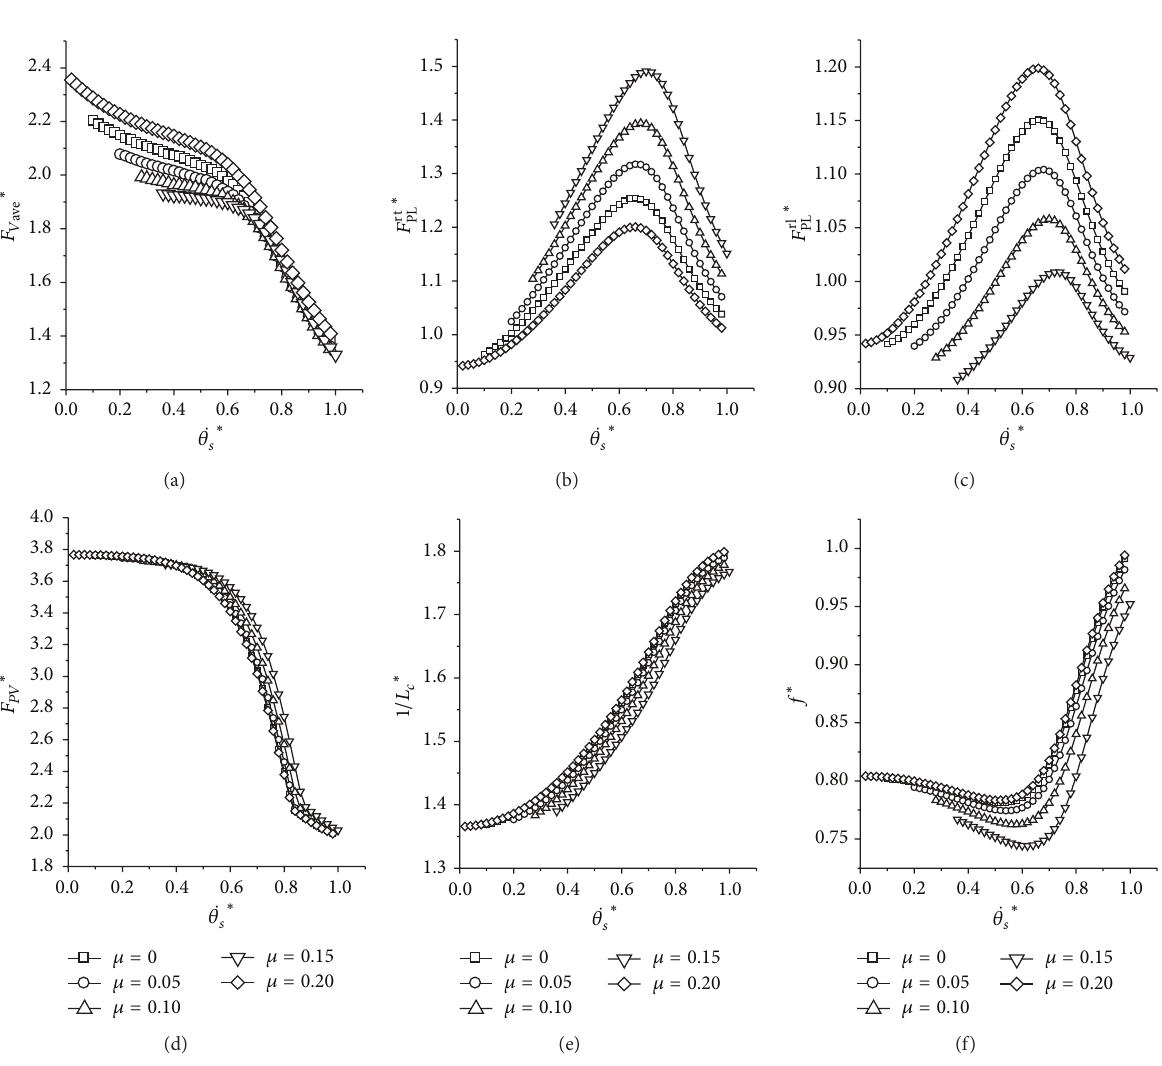
the landing distance lag of a pair of legs is a method to